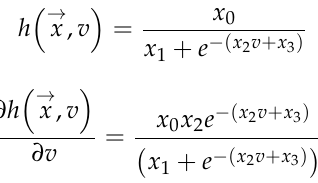
Figure 3. Sigmoid function and the derivative of the Sigmoid function image.